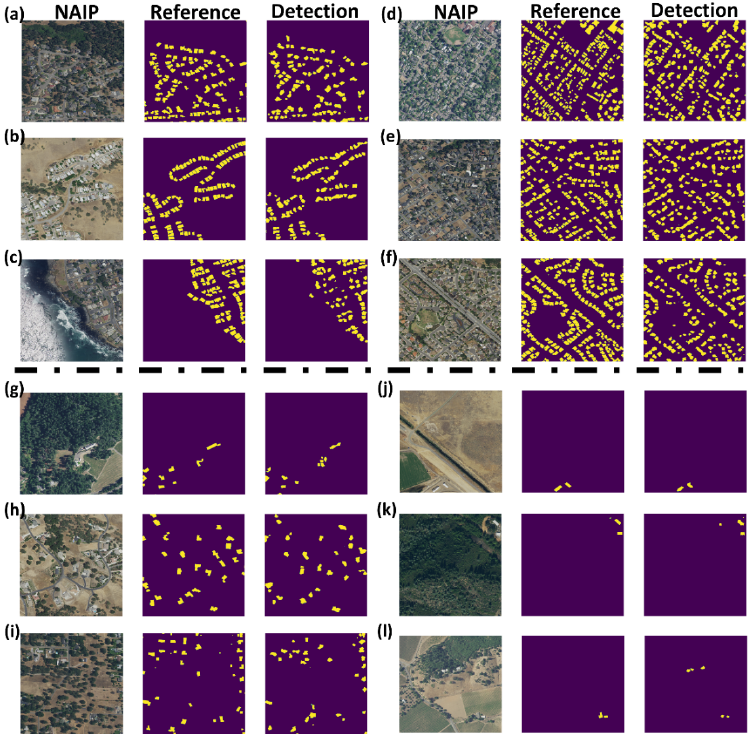
Figure 3. Building footprints detected by our approach over selected sub-regions, representing areas with relatively dense human settlement: ( a – c ) interface WUI and ( d – f ) urban areas; and areas with relatively sparse settlements: ( g – i ) intermix WUI and ( j – l ) rural areas. NAIP RGB imagery and the building footprints obtained from county websites are also included for reference and comparison purposes. Locations of these testing subsets are shown in Figure